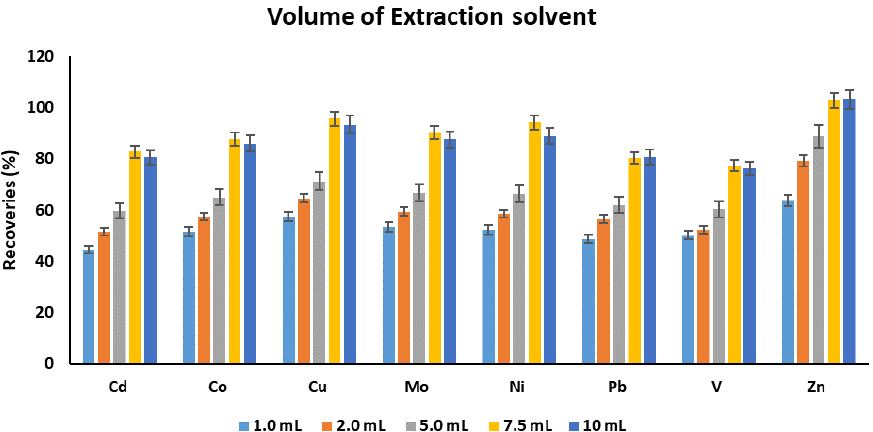
Figure 3. The effect of volume of extraction solvent on the recoveries of target metals. Experimental conditions: sample pH: 4.5, volume of complexing reagent: 200 µL, extraction solvent: chloroform, extraction time: 30 min.